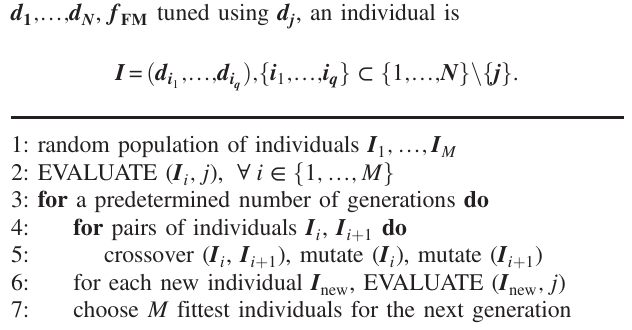
Algorithm 1. Evolutionary algorithm. Geometric parameters